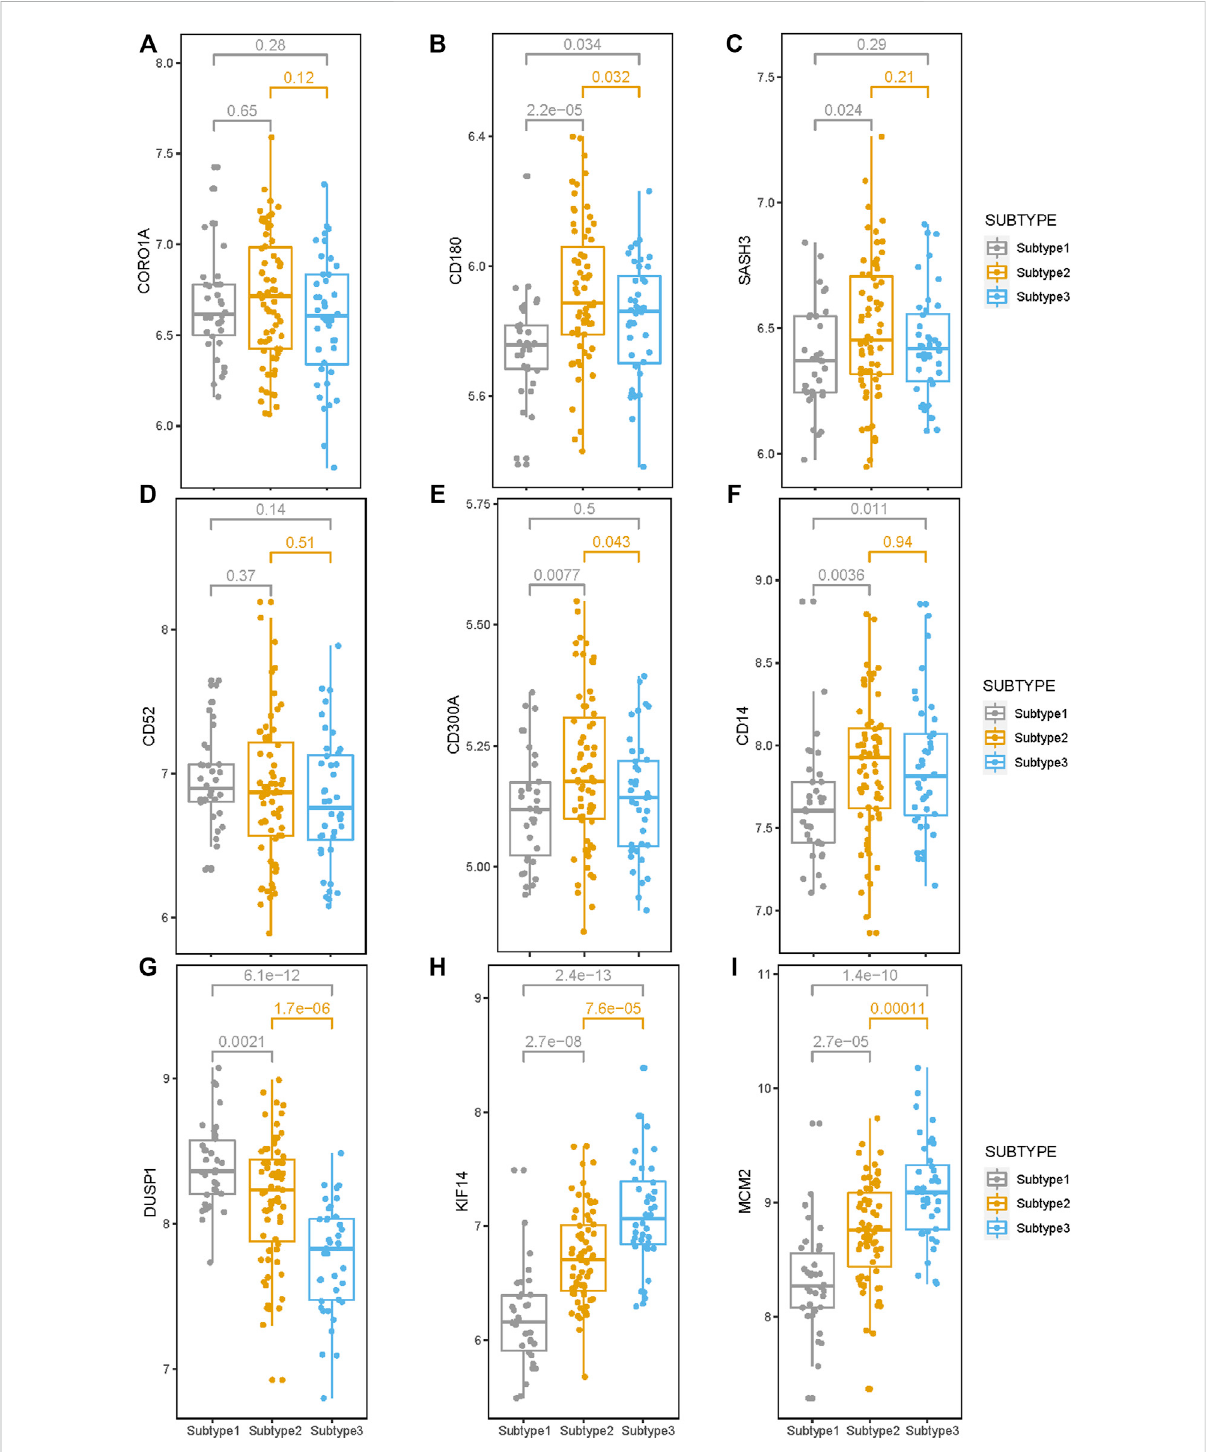
FIGURE 7 Expression levels of the nine survival-related genes in the three subtypes. (A – I) The expression level of the nine survival-related genes in the three subtypes. Expression levels of these seven (CD180, SASH3, CD300A, CD14, DUSP1, KIF14, and MCM2) survival-related genes are signi fi cantly different among these three subtypes. ( p <